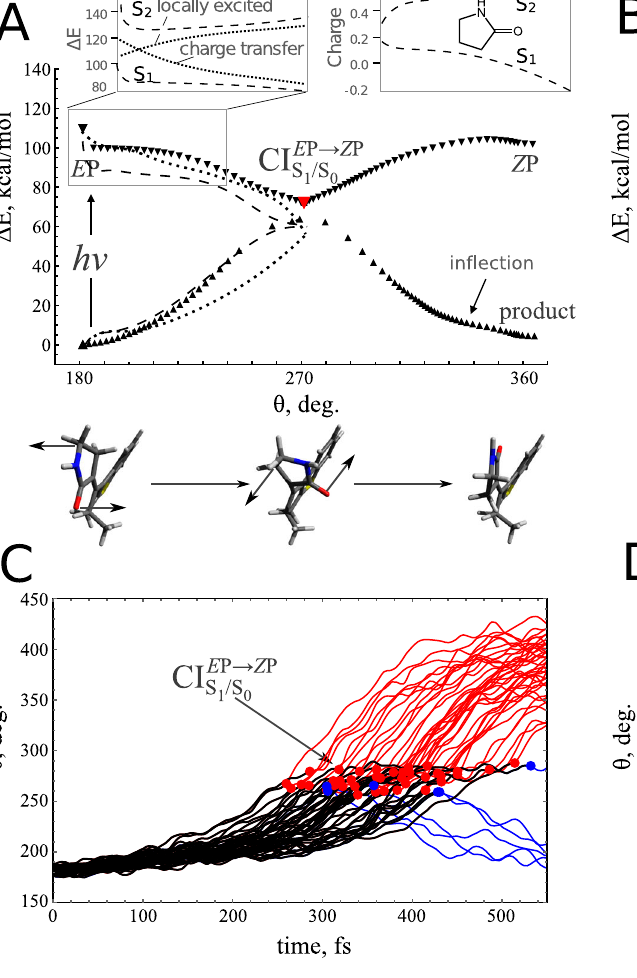
Fig. 4 | Simulated gas-phase photoisomerisation of MTDP. A Projection of the adiabaticminimumenergypath(MEP) E P → Z PoftheMTDPmotoronto θ (seeFig.1 for the de fi nition of θ ) calculated with the SSR method (triangles). The structures below the plot show the geometries of the reactant ( E P), the conical intersection ) and the product (ZP). The arrows indicate a CCW motion. The dashed (CI S 1 = S 0 energy pro fi les correspond to 3-root state-average XMS-CASPT2 energies calcu- lated with a 2 electrons in 2 π -orbitals complete active space. The dotted energy pro fi les show the corresponding 5-root state-average with a 10 electrons in 10 π - orbitals complete active space. The insets display the relationship between the S 1 and S 2 states along the framed region. An avoided crossing between a charge